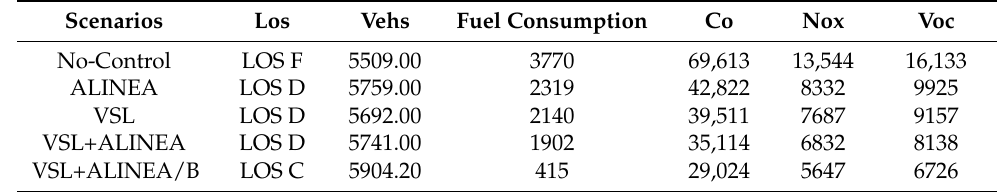
Table 2. Improvement of LOS, fuel consumption, and emissions with the application of specific algorithms